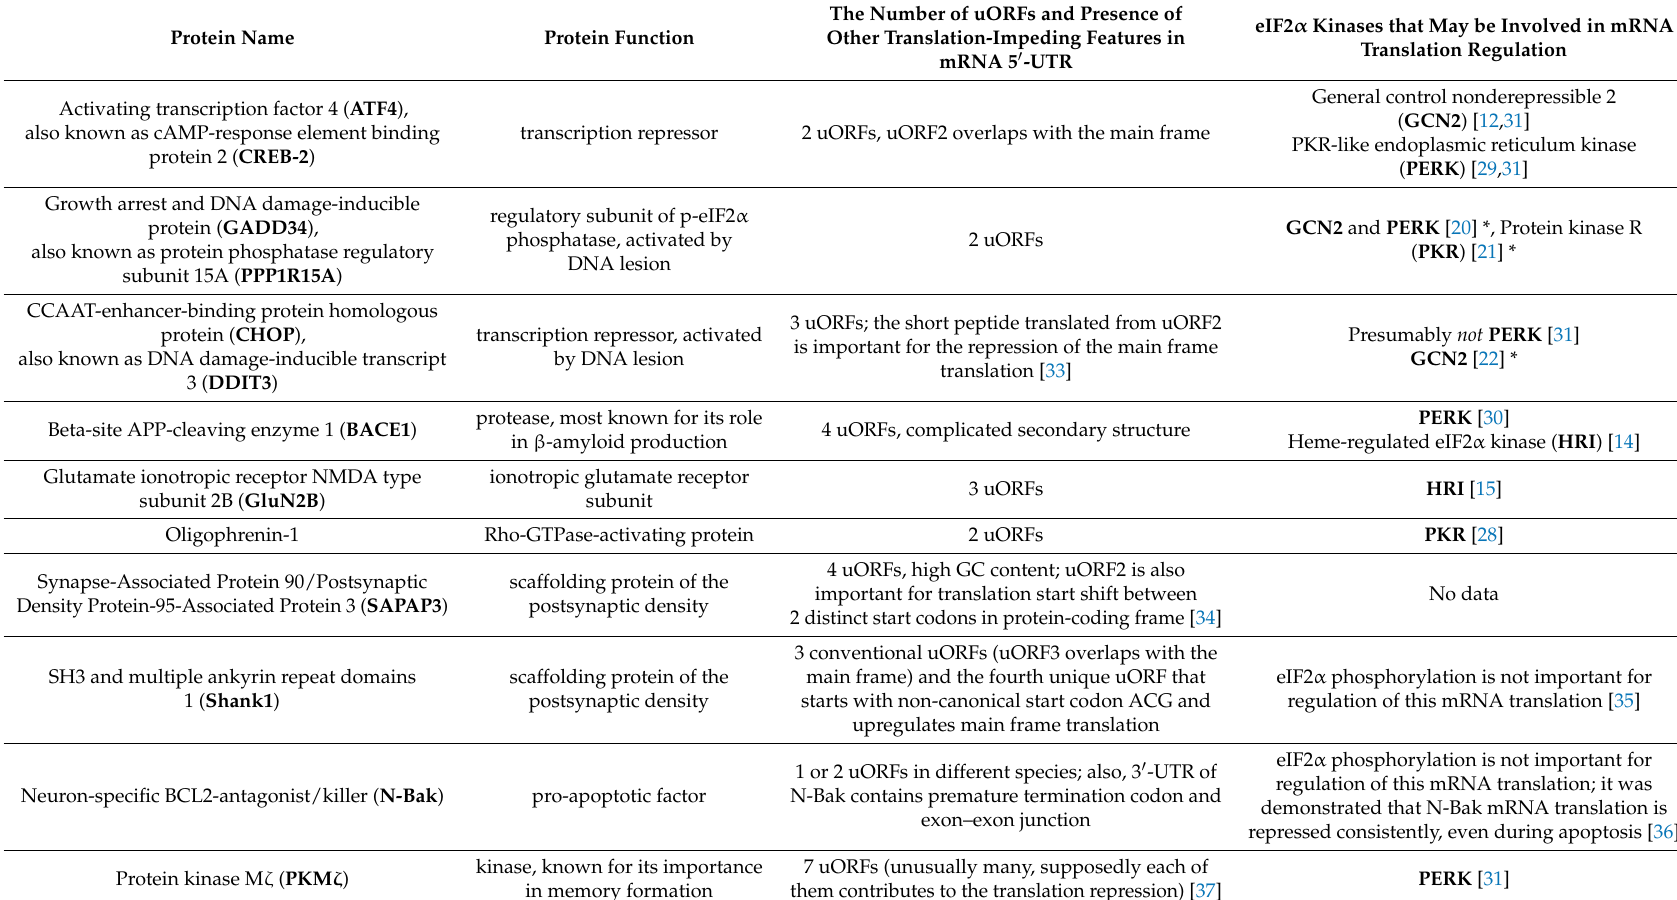
Table 1. Upstream open reading frames (uORF)-containing mRNAs that code proteins important for neuronal function, and their regulation by kinases of α -subunit of eukaryotic initiation factor 2 (eIF2 α